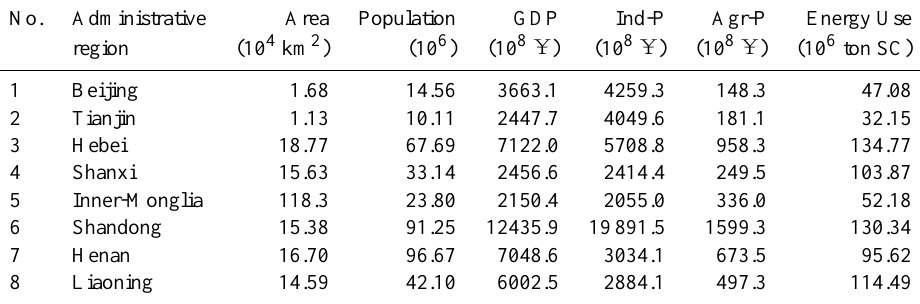
Table 1. Social and economic index of the larger Huabei region in 2003.